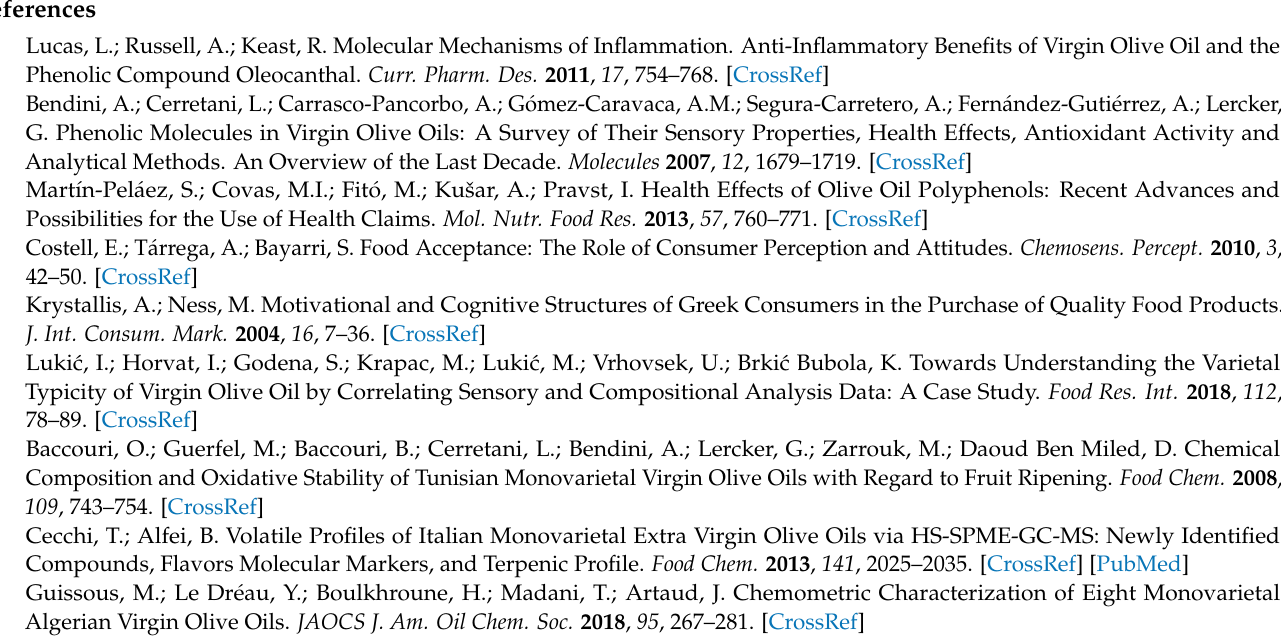
years; Table S2. Basic quality parameters of Leccino virgin olive oils during ripening obtained from two distinct olive orchards (Kaštela and Šestanovac) in three successive crop years; Table S3. Less represented fatty acids and the percentage of total saturated, monounsaturated, and polyunsaturated fatty acids of Oblica virgin olive oils during ripening, obtained from two distinct olive orchards (Kaštela and Šestanovac) in three successive crop years; Table S4. Less represented fatty acids and the percentage of total saturated, monounsaturated, and polyunsaturated fatty acids of Leccino virgin olive oils during ripening, obtained from two distinct olive orchards (Kaštela and Šestanovac) in three successive crop years; Table S5. Results of three-way analysis of variance for sensory properties of Oblica virgin olive oils, obtained from two distinct olive orchards in three successive crop years; Table S6. Results of three-way analysis of variance for sensory properties of Leccino virgin olive oils, obtained from two distinct olive orchards in three successive crop years; Figure S1. Overall quality score of A) Oblica and B) Leccino virgin olive oils, obtained from two distinct olive orchards in three successive crop years, 2010, 2011 and 2012